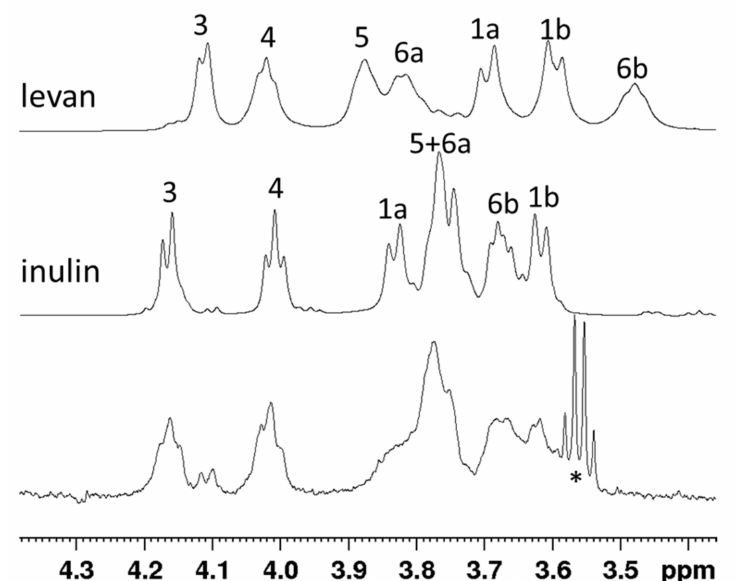
Figure 2. Nuclear magnetic resonance (NMR) results of purified Archaeal fructan produced by Hmc Isc. Stacked plot of the assigned 1D 1 H spectra of two reference samples, levan and inulin, and the produced fructan. The methylene group in the trace of ethanol gives rise to the well-resolved quartet indicated with